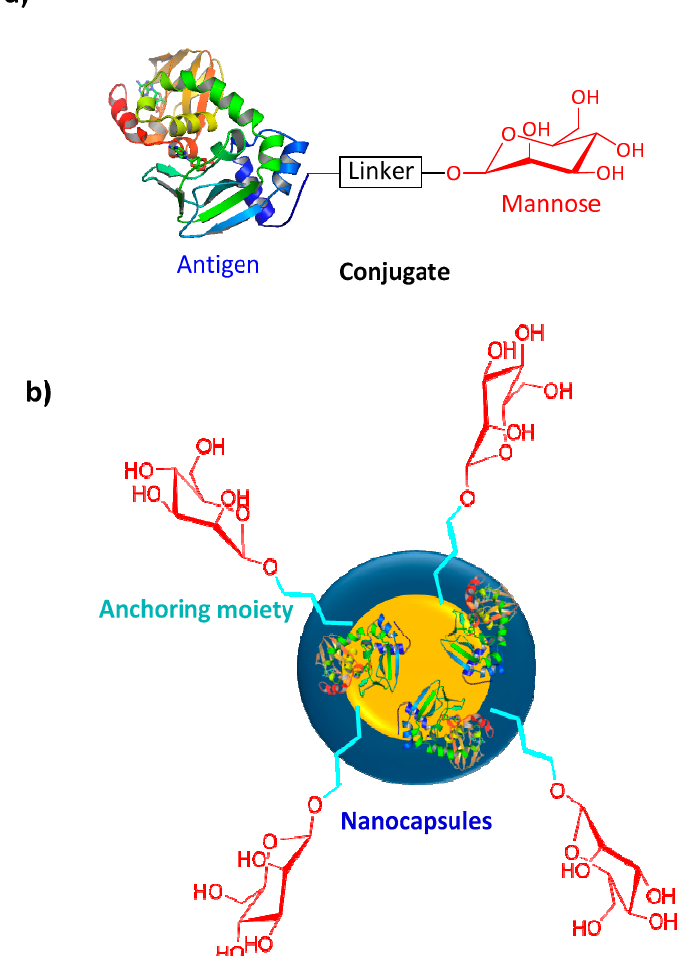
Figure 3. Mannosylated peptide/protein-based vaccine constructs: ( a ) antigenic peptide/protein